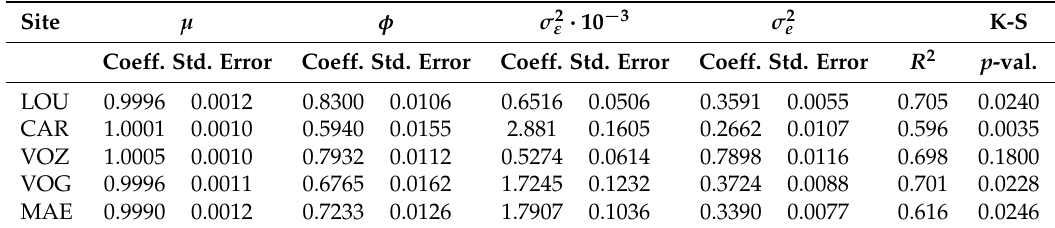
Table 5. Estimation results for the calibration model MIII